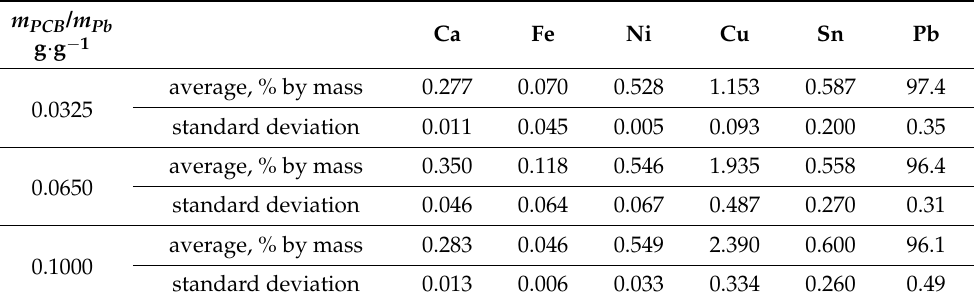
Table 7. Chemical compositions of the lead ingots after melting with PCB pyrolyzate “server”, averages and standard deviation of 3